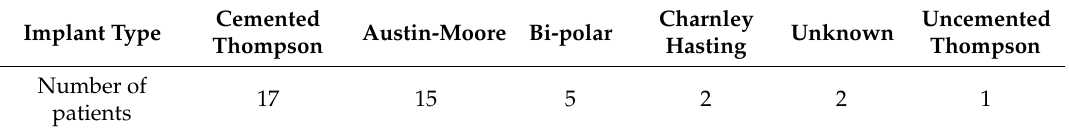
Table 3. Type of hemaiarthroplasties in primary